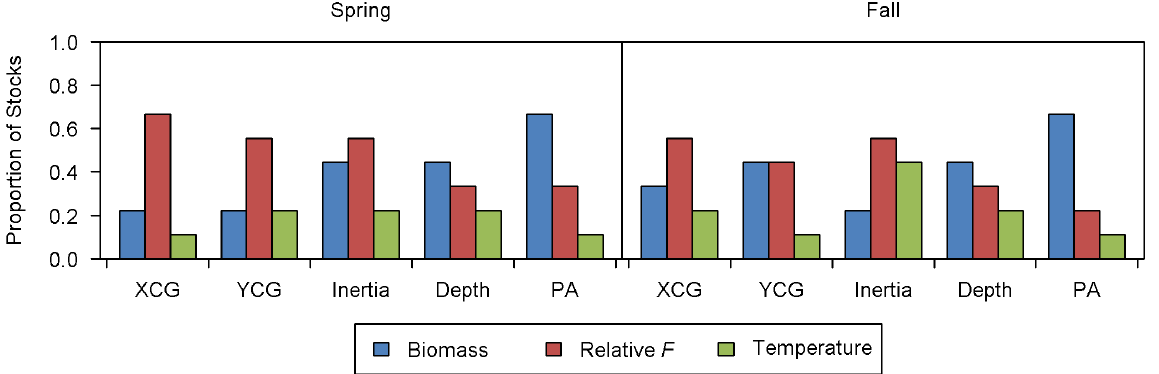
Fig 2. Proportion of stocks for which a variable was the most important predictor, by spatial indicator. Spatial indicators and associated units are: geographically referenced longitude and latitude of the center of gravity (XCG and YCG, respectively; km), inertia (km 2 ), depth (m) and positive area (PA; km 2 ). Predictor variables are: Northeast Fisheries Science Center (NEFSC) bottom trawl survey stratified mean kg per tow (biomass; kg), catch/NEFSC stratified mean kg per tow (relative F ) and NEFSC stratified mean bottom temperature (˚C). Proportions may not sum to one in the case of